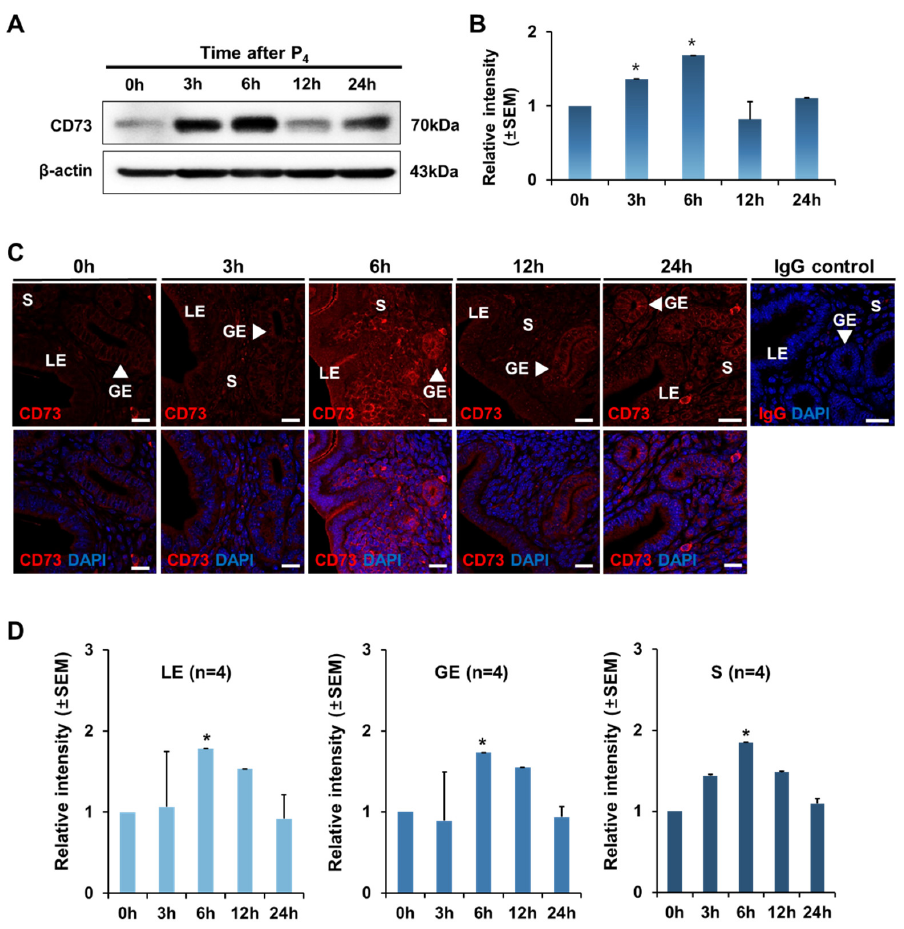
Figure 4. The effect of progesterone on CD73 expression in ovariectomized (OVX) mouse uterus. ( A ) Western blot analysis for relative levels of CD73 in the uterus of the OVX mice after P 4 treatment for 0, 3, 6, 12, and 24 h (each group n = 4). β-actin was used as a loading control. ( B ) Quantitative Western blot analysis showed the relative expression of CD73 in the uterus of the OVX mice after P 4 treatment. The one-way ANOVA analysis was used to calculate p -value, * p -value < 0.01. ( C ) Confocal microscopic images represent the localization and expression level of CD73 (red) and DAPI (blue) in the uterus of the OVX mice treated with P 4 . Normal rabbit IgG (IgG control) was used as a negative control for a secondary antibody. LE, luminal epithelium; GE, glandular epithelium; S, stroma. The white scale bars indicate 20 μm. ( D ) Quantitation of the relative levels of CD73 in the uterus of P 4 -treated OVX mice using imaging software Carl Zeiss ZEN 2012 in luminal epithelium (LE), glandular epithelium (GE), and stroma (S), respectively. The relative expression value was based on the value at 0 h after P 4 treatment. Four animals in each group were examined.